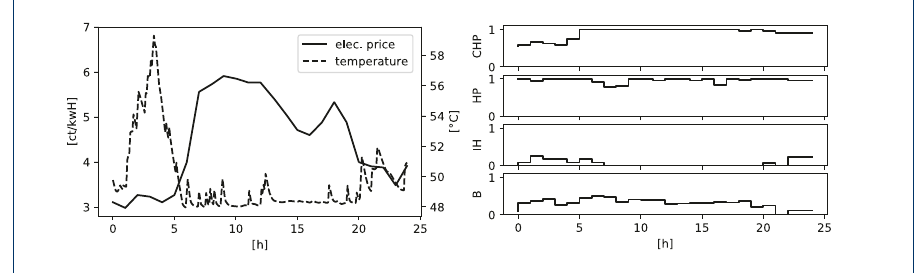
Figure 3 Exemplary results for the heating grid in grid temperature and converter set points